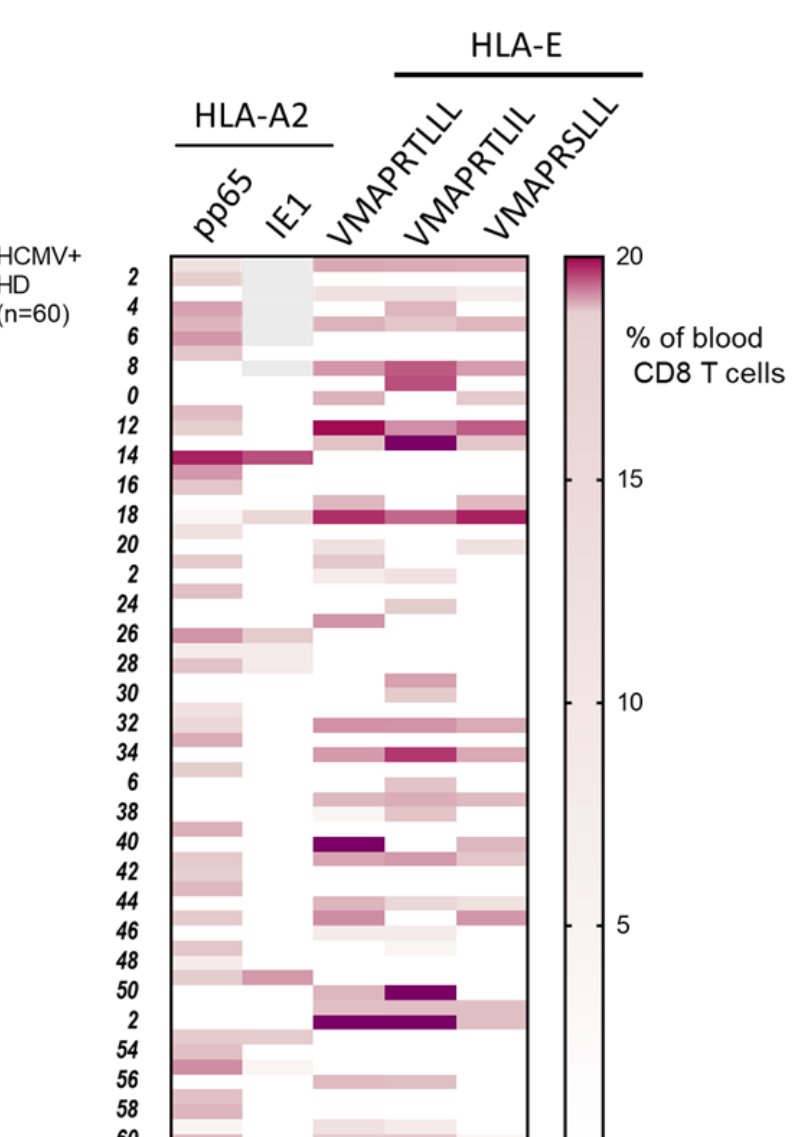
Figure 2. Patterns of long-lasting HCMV-specific CD8 T cell subsets detected in HCMV+ adults. Heat map shows the presence and the specificity of the HCMV-specific CD8 T cells detected for 60 HCMV+ HD out of the cohort study. HCMV-specific CD8 T cell subsets were detected and quantified by flow cytometry after immunostaining using a set of pMHC class I tetramers containing HLA-A2pp65, HLA-A2IE1 and HLA-EUL40 (HLA-E/VMAPRTLLL, HLA-E/VMAPRTLIL, HLA-E/VMAPRSLLL) tetramers. Immunostainings for the five pMHC tetramers were performed in parallel during the same experiment for each PBMC sample. Results display the percentages of the HCMV-specific CD8 T subsets among total blood CD8 T cells using a color